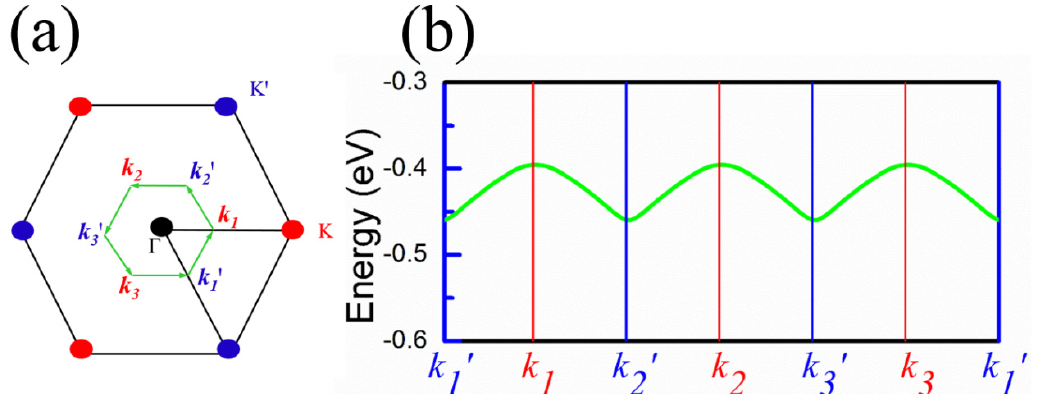
Figure 3. The first Brillouin zones for C-1 configuration ( a ). The green arrows indicate a k -point loop from k 1 ꞌ to k 3 , where k n ( n = 1, 2, 3) (red) and k n ꞌ ( n = 1, 2, 3) (blue) are the k -point positions for the highest band energies of InSe along Γ –K , and Γ –K ′ , respectively. ( b ) The top valence band of InSe along the k 1 ꞌ to k 3 k -point loop.